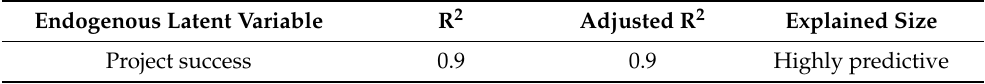
Table 11. R-square